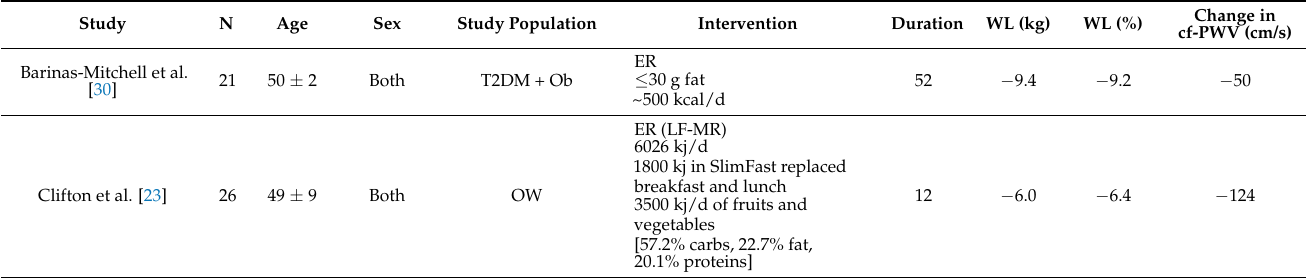
Figure 1. PRISMA 2020 flow diagram for studies included in this report. Table 1. Details pertaining to the studies included in this report.